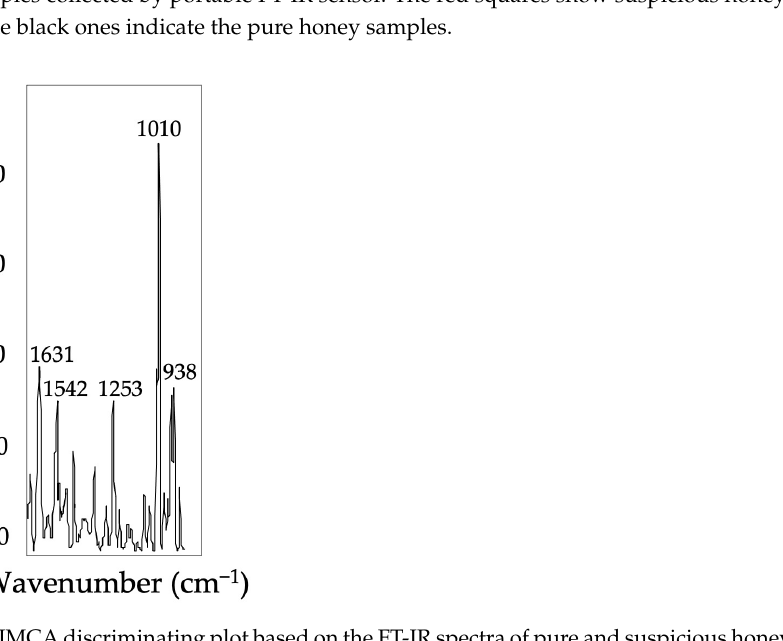
Figure 3. SIMCA discriminating plot based on the FT-IR spectra of pure and suspicious honey samples using the portable FT-IR sensor, showing bands and regions responsible for the class separation. *arbitrary units.